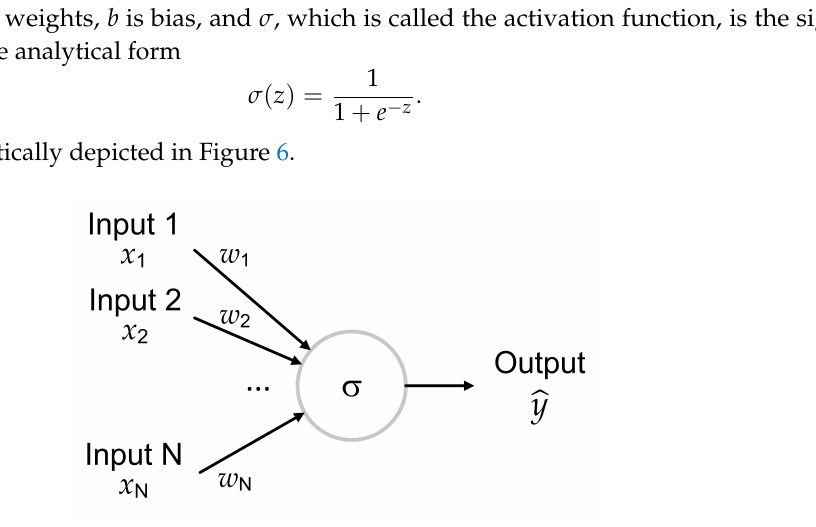
Figure 6. A schematically depicted neuron. It applies a non-linear transformation to the inputs with the sigmoid activation function to obtain its output.